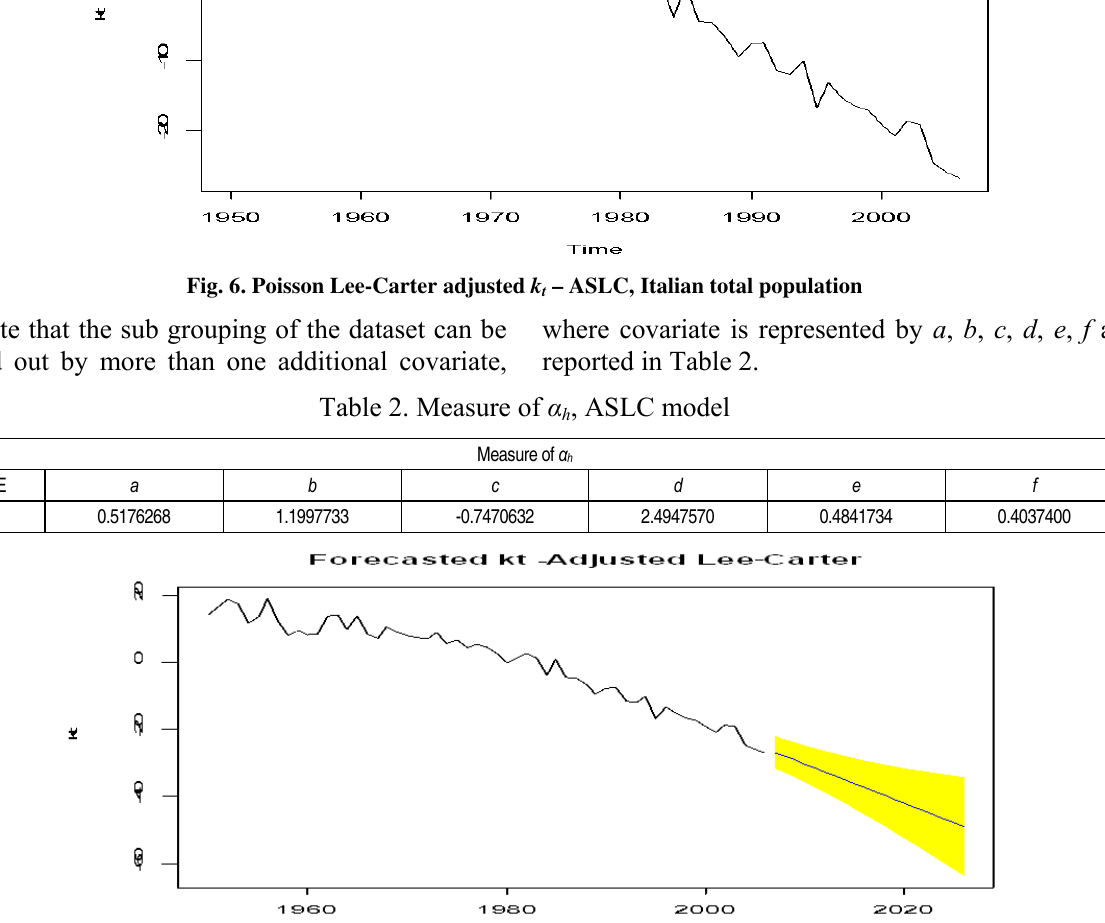
Fig. 7. Poisson Lee-Carter forecasted k t –- ASLC, Italian total population